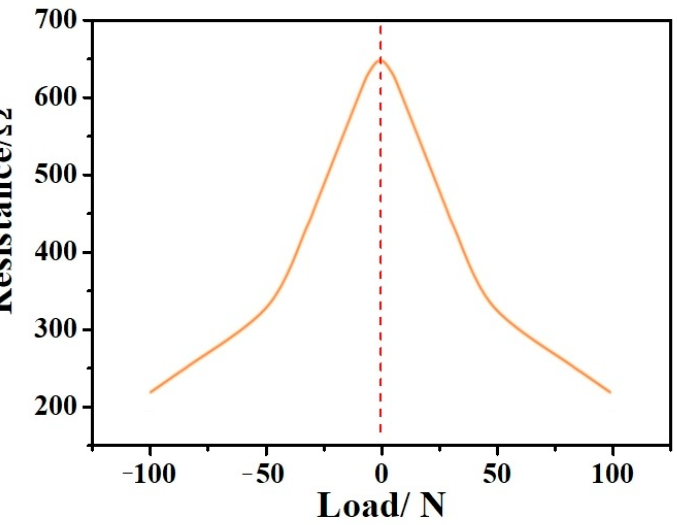
Figure 8. Resistance distribution fitting curve of the sample sponge under one cyclic loading pres ‐ sure.